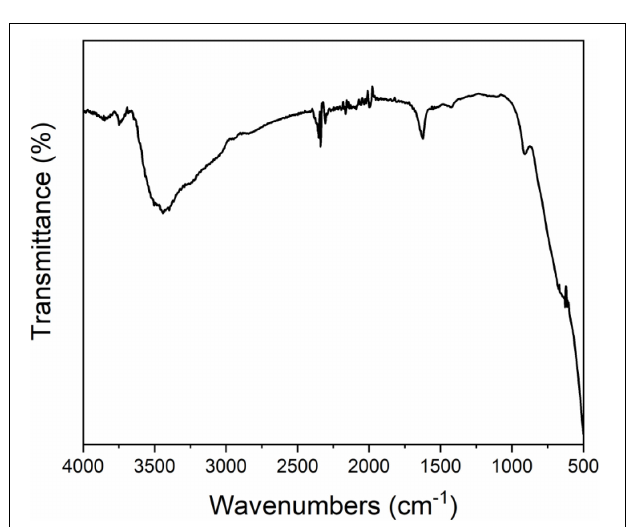
FIGURE 2 | FTIR spectrum of TiO 2